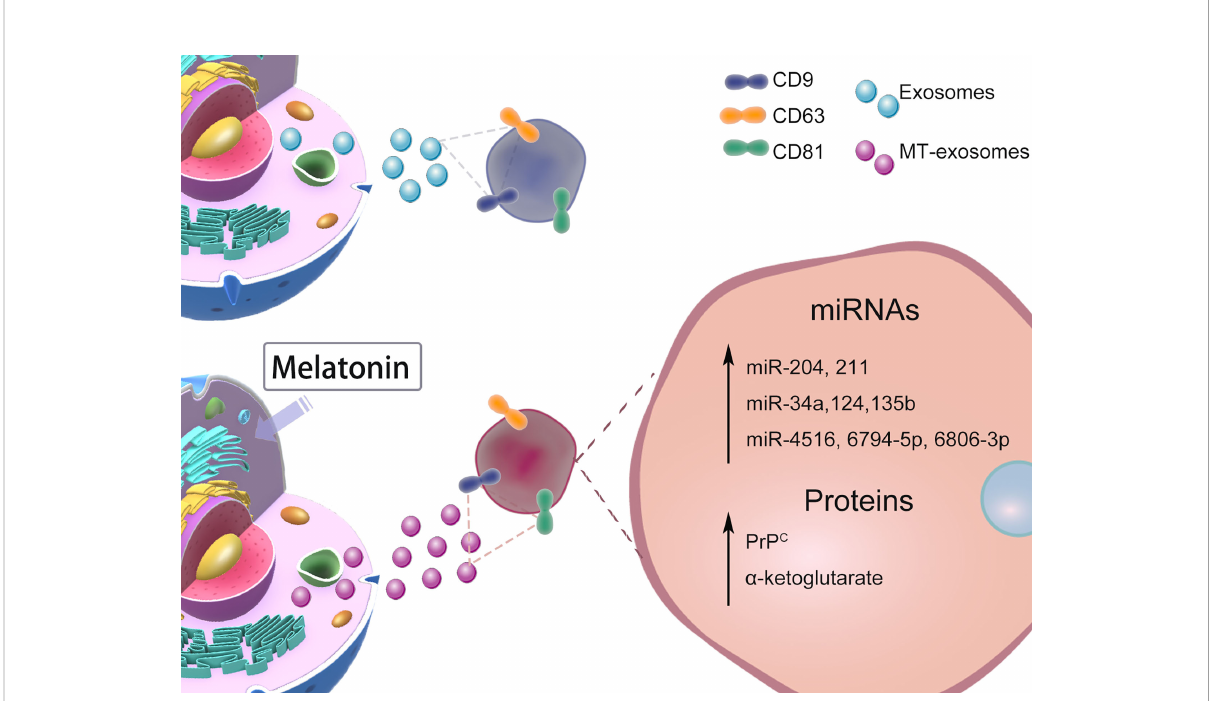
FIGURE 2 Effects of Melatonin Pretreatment on Exosome heterogeneity: size, production, miRNAs, proteins. The heterogeneity of the effect of melatonin pretreatment on exosomes is still controversial. We mainly list the changes in size, production, and content of exosomes reported by current related